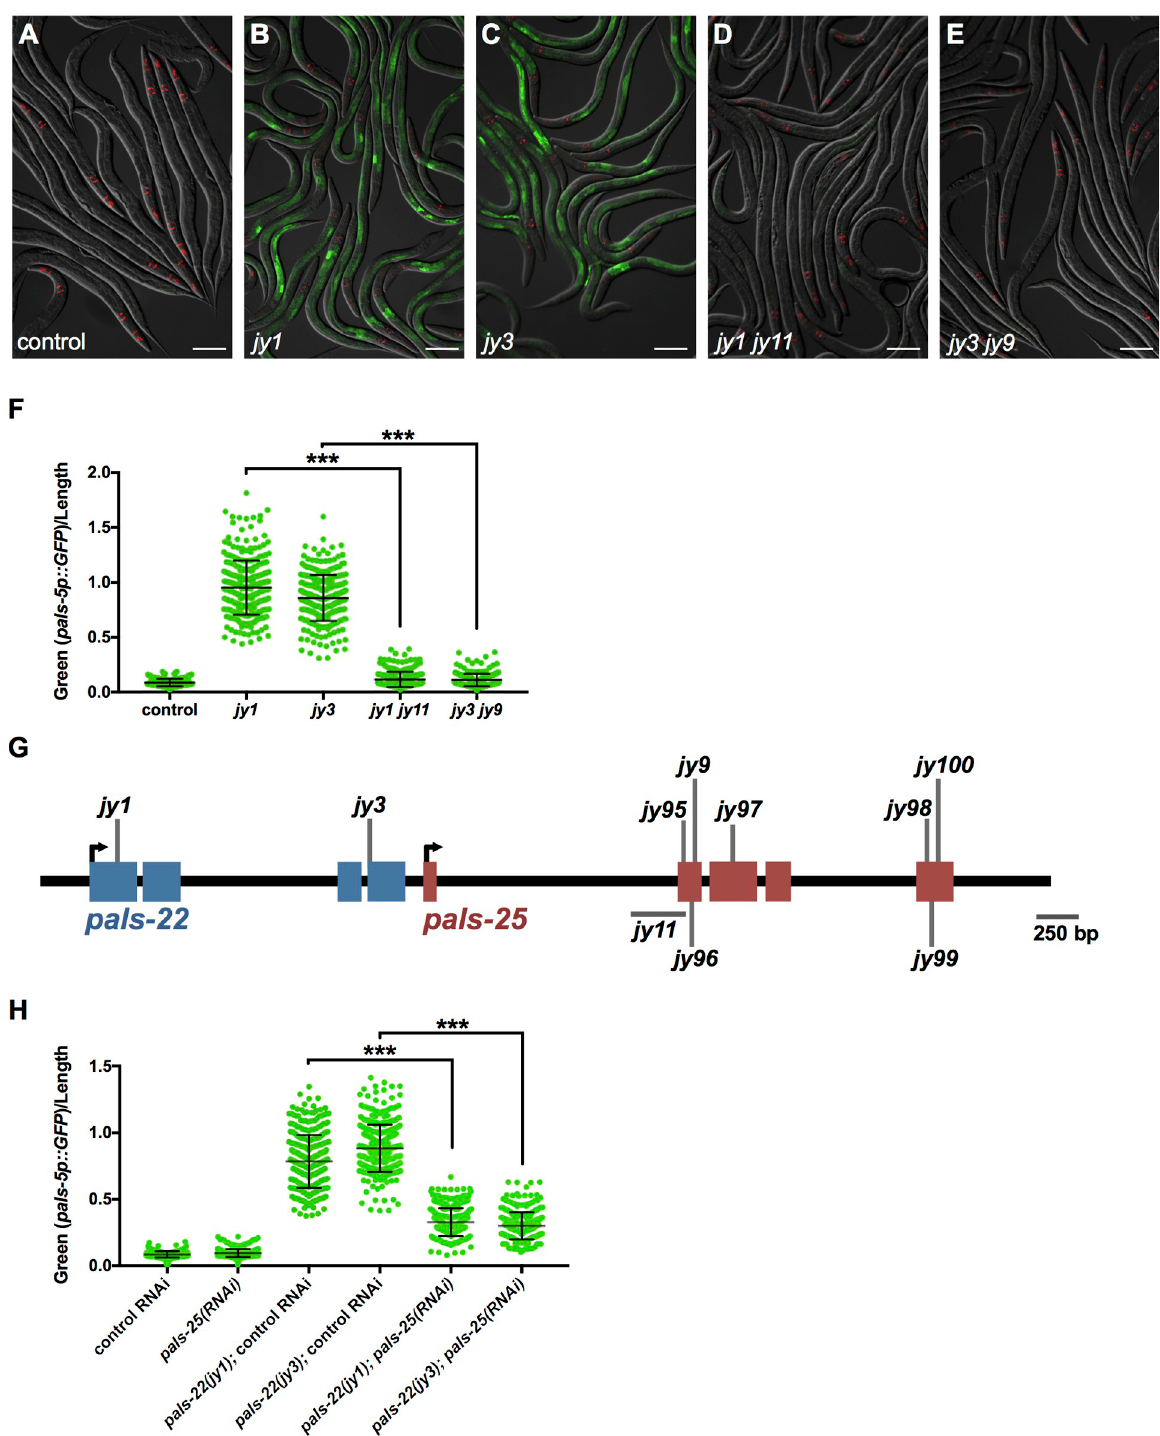
Fig 1. pals-25 is required for increased pals-5p :: GFP expression in pals-22 mutants. (A-E) Mutants isolated from pals-22 suppressor screens show decreased expression of the pals-5p :: GFP reporter. Shown are (A) wild-type, (B) pals-22(jy1) , (C) pals-22(jy3) , (D) pals-22(jy1) pals-25(jy11) , and (E) pals-22(jy3) pals-25(jy9) animals. Green is pals-5p :: GFP , red is myo-2p :: mCherry expression in the pharynx as a marker for presence of the transgene. Images are overlays of green, red and Nomarski channels and were taken with the same camera exposure for all. Scale bar, 100 μ m. (F) pals-5p :: GFP expression quantified in pals-22 suppressor mutants using a COPAS Biosort machine to measure the mean GFP signal normalized by length of individual animals, indicated by green dots. Mean signal of the population is indicated by black bars, with error bars as SD. Graph is